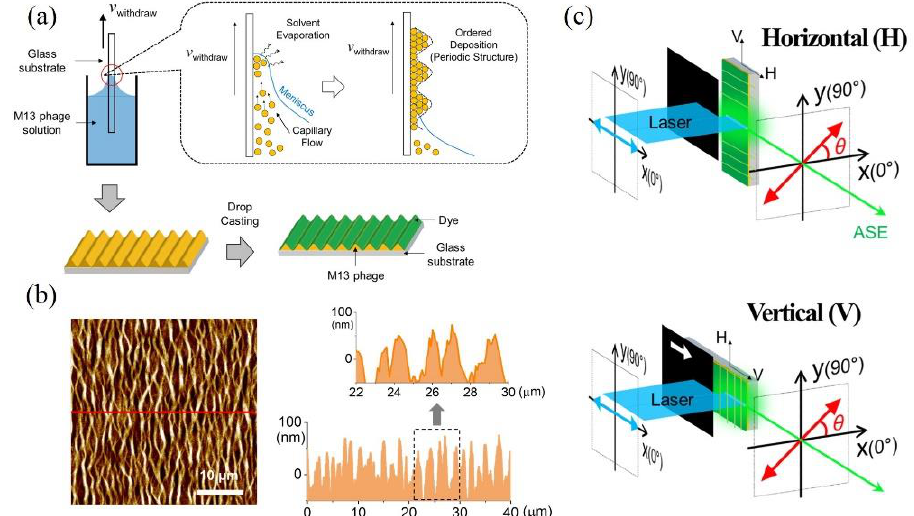
Figure 1. ( a ) After the periodic structure of M13 bacteriophage is formed by the dip-coating method, where evaporation induces self-assembly, dye (Alexa-Flour488) is deposited on the ordered structure of M13 bacteriophage thin film. ( b ) AFM image showing the corrugated structure of M13 bacterio- phage. ( c ) Polarized edge emission is measured to obtain the stripe length dependence of amplified spontaneous emission (ASE), where the optical stripe generated by a 400 nm laser is either horizontal (H) or vertical (V) to the corrugated direction of M13